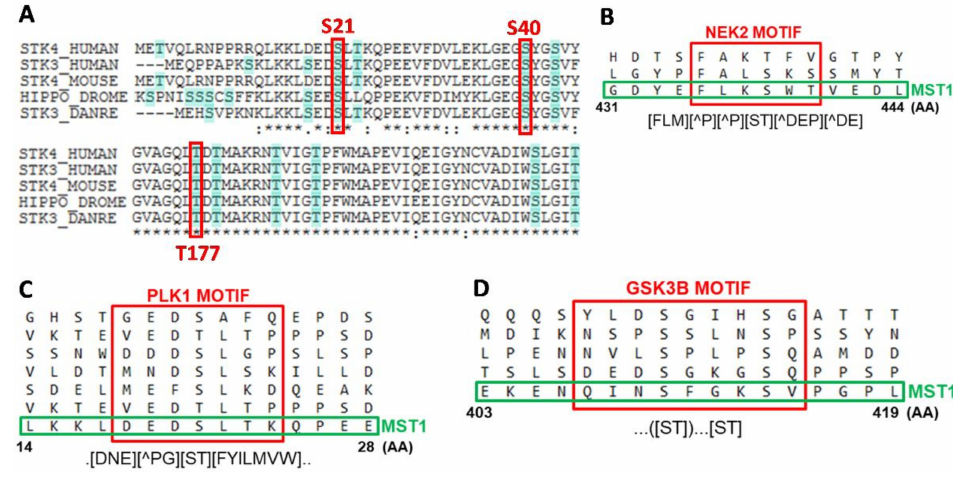
Figure 2. Bioinformatic analysis of MST1 protein residues identified to be phosphorylated. ( A ) Conservation of positions of S21, S40, and T177 residues in STK3/STK4 sequences of humans, mice, flies, and fish. ( B – D ) Sequences of motifs recognized by individual kinases around S438, S21 and S414 residues according to the ELM resource. Common motifs are shown in the syntax of Regular Expression Parser and Visualizer (https://github.com/CJex/regulex). (AA) symbol represents AA constrained in the motif, (AA) symbol represents AA excluded from the motif and dot symbol represents random